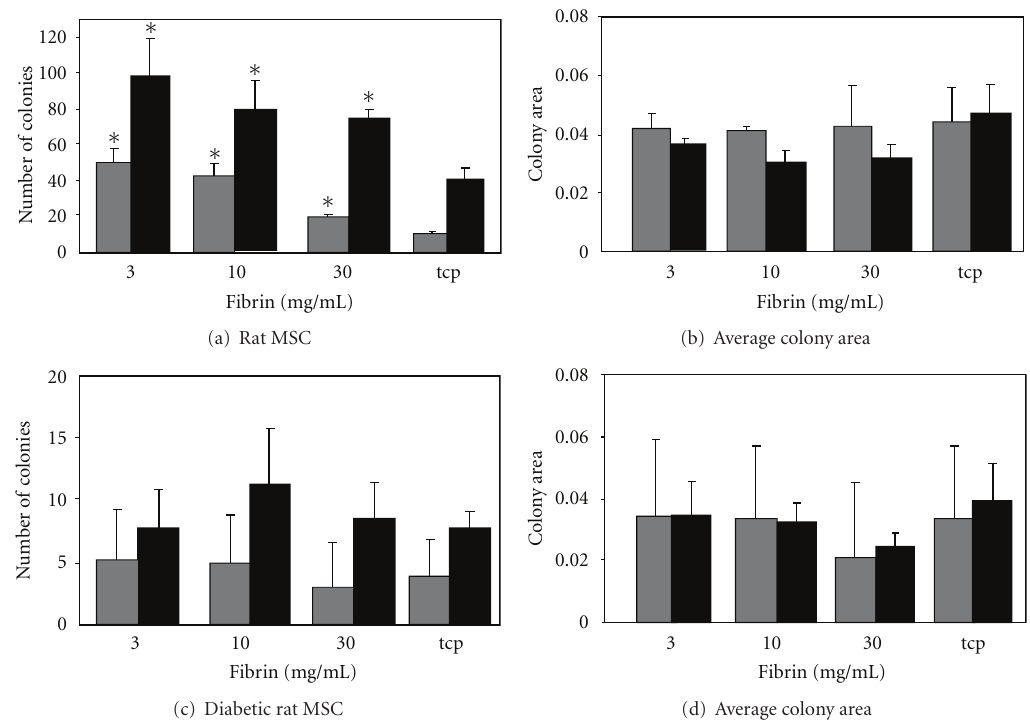
Figure 2: E ff ects of fibrin surfaces on healthy and diabetic rat MSC. MSC isolated from young and diabetic rats were grown on fibrin gels for 7 days, and then 1000 cells were seeded into the CFU assays under osteogenic conditions. ALP-positive (grey) and total colony numbers (black) were calculated for normal rat MSC (a) as well as the mean size of the colonies (b). CFU numbers for MSC from were also calculated (c) as well as the mean colony size (d). ∗ Denotes a statistically significant di ff erence from the other groups.